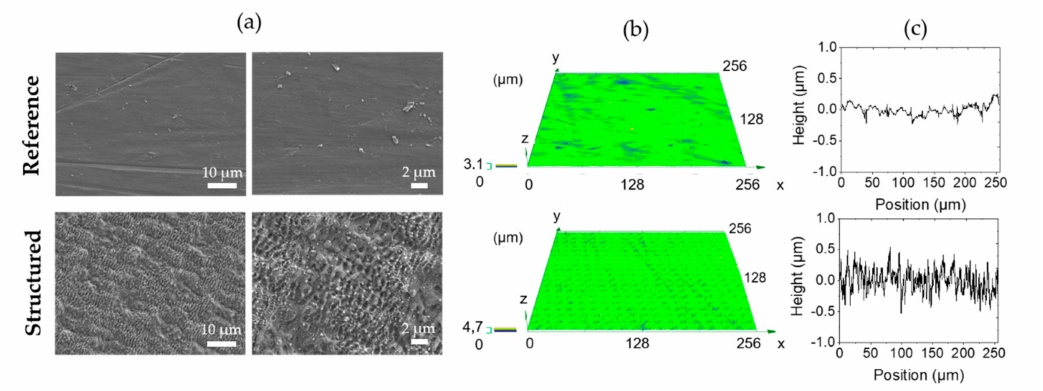
Figure 1. Surface characteristics of the reference and the structured surface. ( a ) SEM images ( b ) CLSM mapping and ( c ) elevation profile